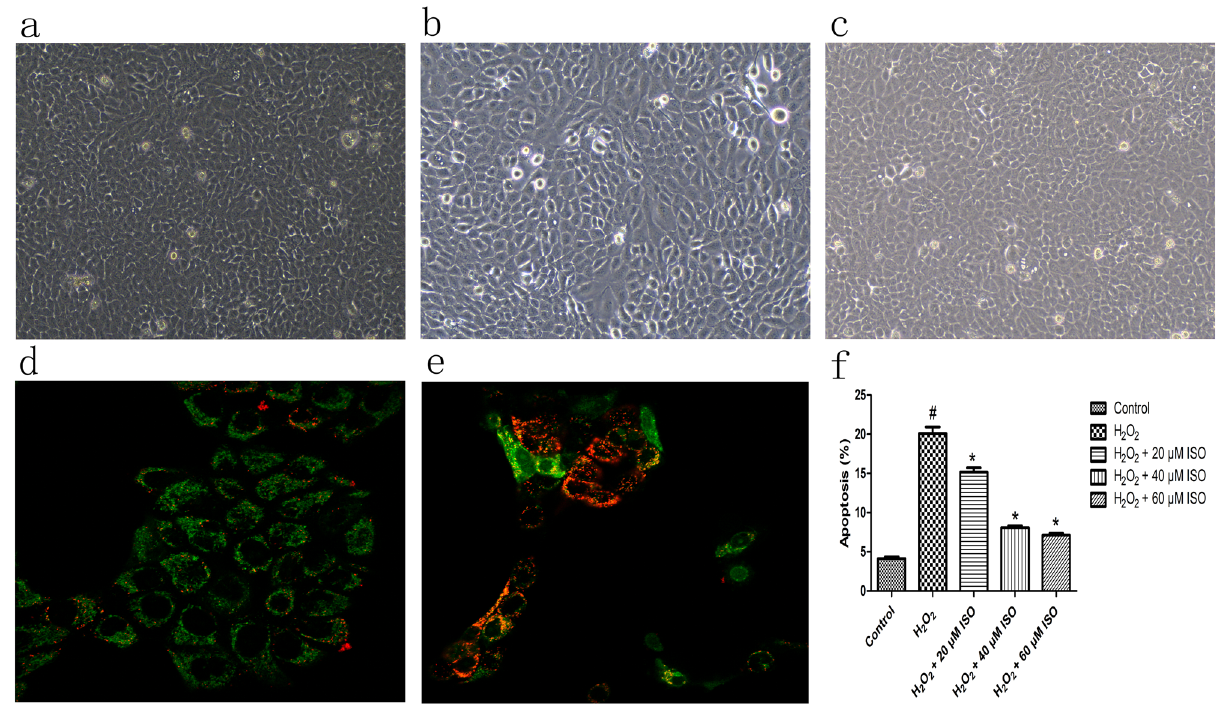
Figure 2. The effect of isorhamnetin (ISO) on the morphology of HaCaT cells injured by H 2 O 2 (40 × magnification). ( a ) Untreated HaCaT cells showing a normal cell morphology. ( b ) HaCaT cells stimulated with 600 μM H 2 O 2 showed increased apoptosis. ( c ) HaCaT cells treated with 600 μM H 2 O 2 + 40 μM ISO group, compared with H 2 O 2 -only treatment, showing improvement in cell morphology and a reduction in the number of apoptotic cells. ( d ) Confocal microscopy images of HaCaT cells were treated with 600 μM H 2 O 2 to detect mitochondrial permeability; weak red fluorescence and strong green fluorescence indicates disruption of mitochondrial membrane potential. ( e ) Confocal microscopy of cells treated with 600 μM H 2 O 2 + 40 μM ISO treatment, showing stronger red fluorescence. ( f ) Apoptosis rate of cells treated with hydrogen peroxide as assessed by PI staining and flow cytometry. Control, untreated HaCaT cells; H 2 O 2 -alone group, HaCaT cells treated with 600 μM H 2 O 2 ; all H 2 O 2 + ISO were 600 μM H 2 O 2 . Graphs show the mean ± SD values of three replication. One-way ANOVA followed by Tukey’s post-hoc test. # indicates significant differences ( p < 0.05) from the control group. * indicates significant differences ( p < 0.05) from the treatment of HaCaT cells with 600 μM H 2 O 2